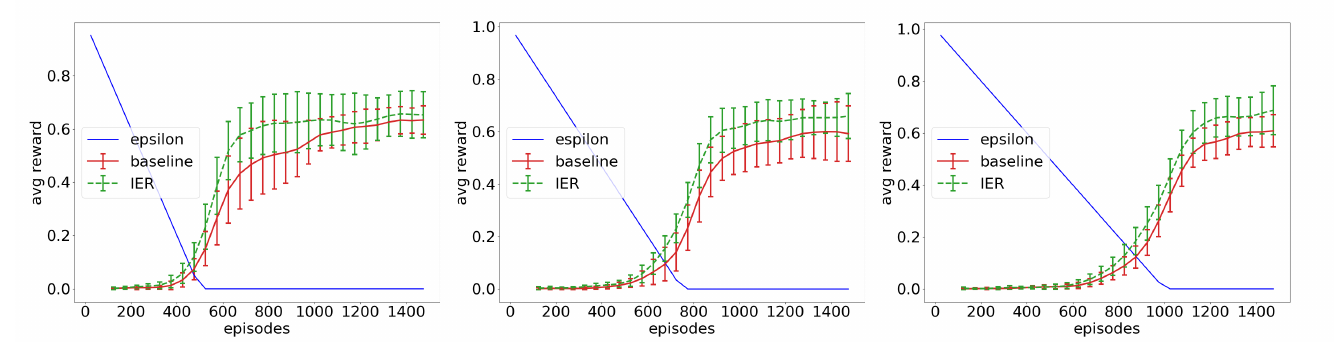
Figure 6. The best results among all conducted experiments with state-encoding CE. The solid red line represents the classical ER serving as baseline to compare with. The dashed green line shows the average reward of the IER approach. The blue line depicts the decaying epsilon. The lines for IER and the baseline represent the repetition averages. ( t expl = 500. t expl = 750. t expl = 1000.